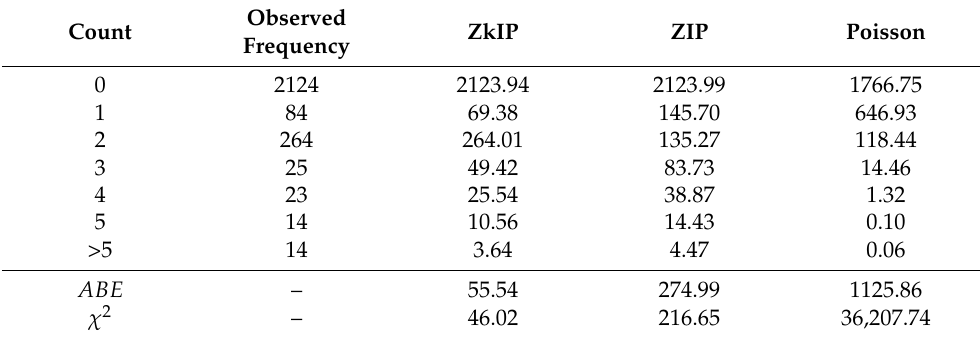
Table 13. Observed and expected frequencies of the off days